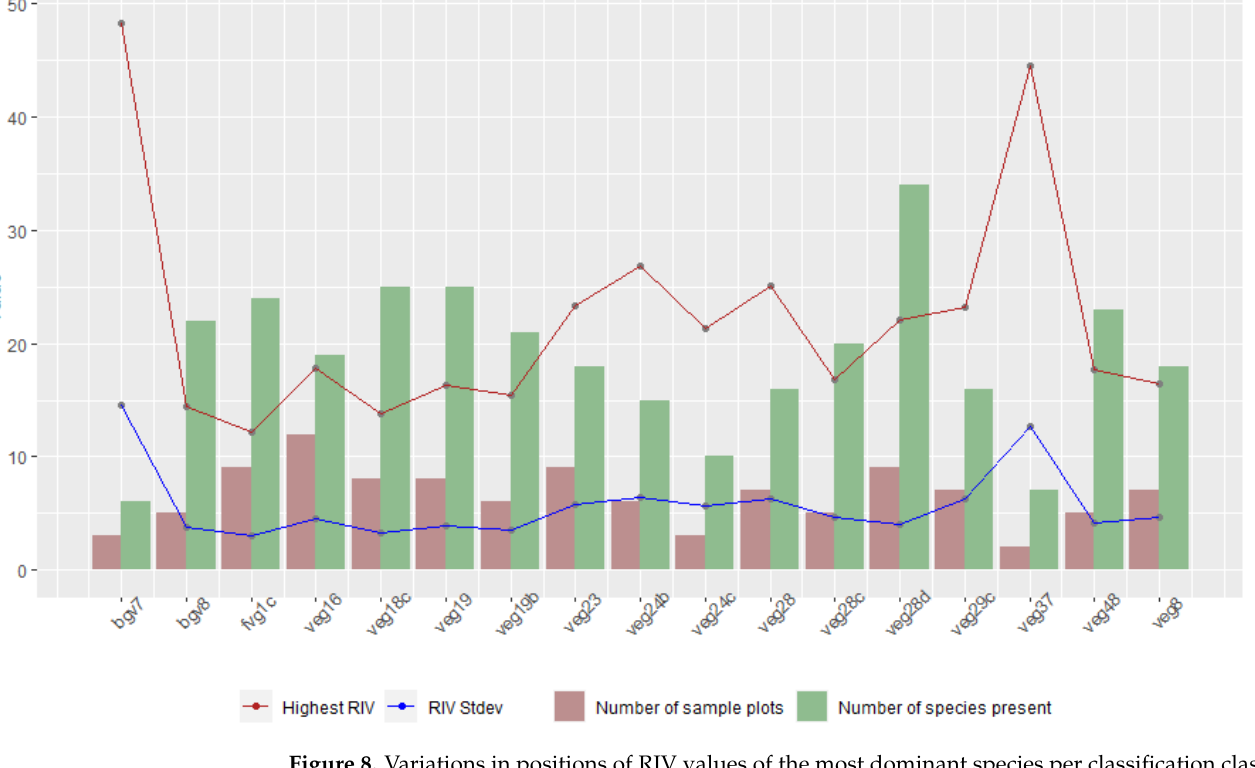
Figure 8. Variations in positions of RIV values of the most dominant species per classification class, and the RIV standard deviation for all species in each classification class, in comparison to the number of sample plots and all species present. Distinct peaks in the highest RIV and RIV standard deviation values are consistent with low numbers of sampling plots and species present in these plots for the classification classes Bgv7 and Veg 37.